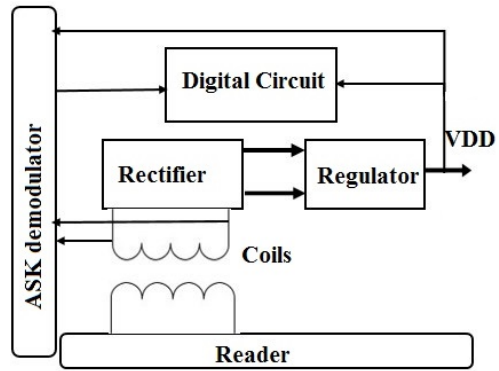
Figure 1. Analog front ‐ end of a RFID tag implementing an amplitude shift keying demodulator [8]. Reproduced with permission from [8], IEEE, 2009.